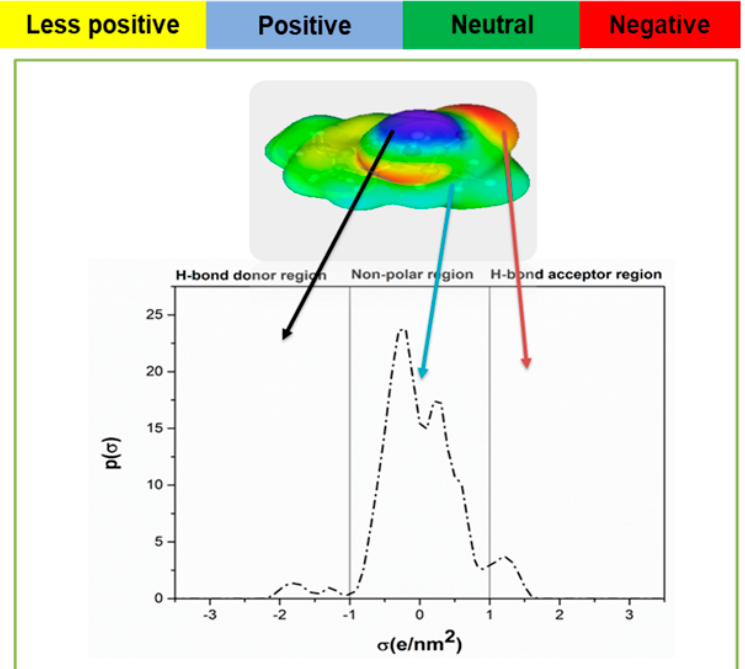
Figure 1. σ -profile of Ibf evaluated using COMSO-RS .